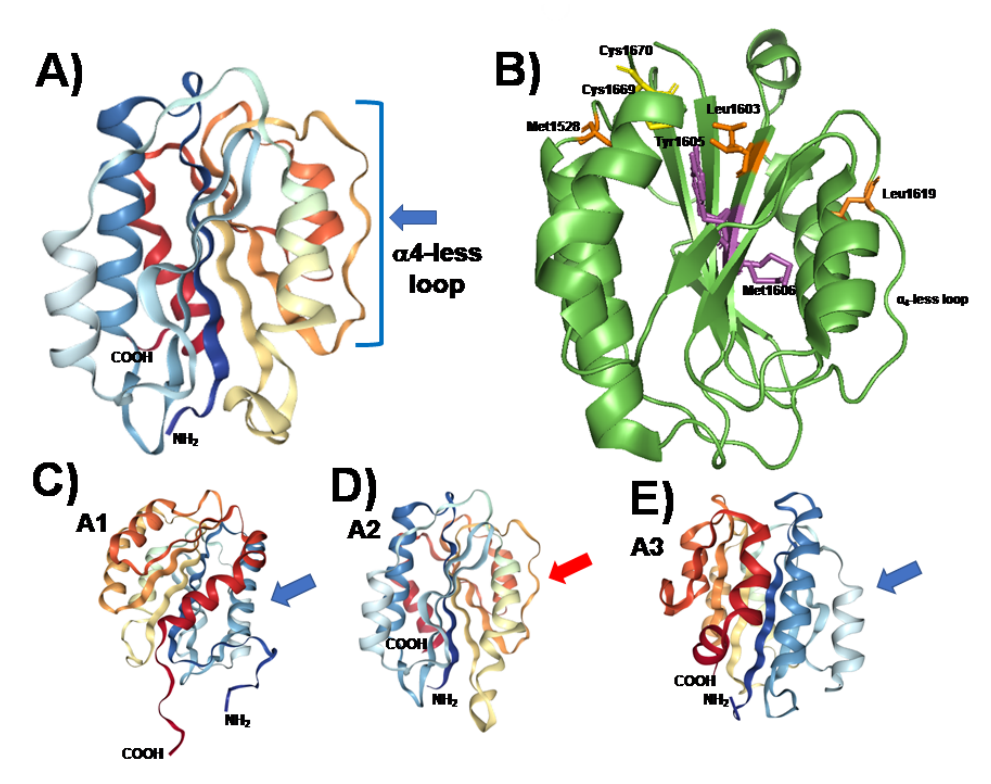
Figure 4: A) Crystal structure of calcium-bound human VWF A2 domain (PDB accession code 3ZQK), shown in cartoon representation . The central β-sheets are encircled by α-helices. The blue arrow indicates the α4-less loop.. B) Structure of human A2 domain of VWF (PDB accession code 3GXB, shown in the same prospective of panel A) . The figure shows the interactions between the vicinal Cys1669–Cys1670 peptide bond (yellow) interacting with some apolar side chains of amino acids in the β4-strand, such as Leu1603 (orange) and Tyr1605- Met1606 (magenta). The Ile1619 (orange) in the α -less loop is also shown. C), D and E) panels show the cartoon representation of the 4 A1 (PDB 1AUQ) , A2 (PDB 3GXB), and A3 (PDB 1AO3) domain of VWF, respectively. Note the similar global structures of the three domains containing a central region composed of β-sheets encircled by α-helices. The major structural difference resides in the presence of the absence of the α4-loop, substituted by a loop (red arrow). NH - and COOH- represent the N- and C- terminal ends of the domains. The figure 2 is generated by the program Pymol (v.